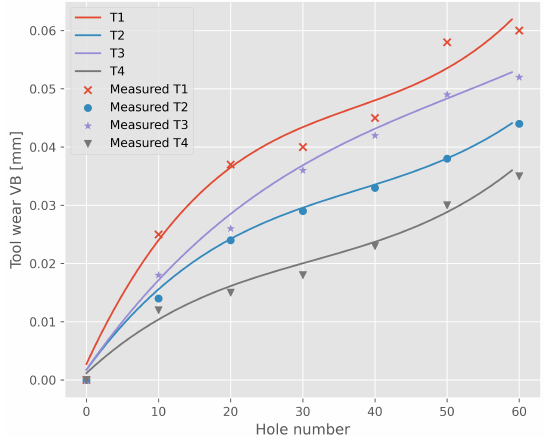
Figure 2. Tool wear curves obtained via third-order polynomial interpolation of the measured values for the experimental tests T1, T2, T3, and T4 are reported in Table 1.